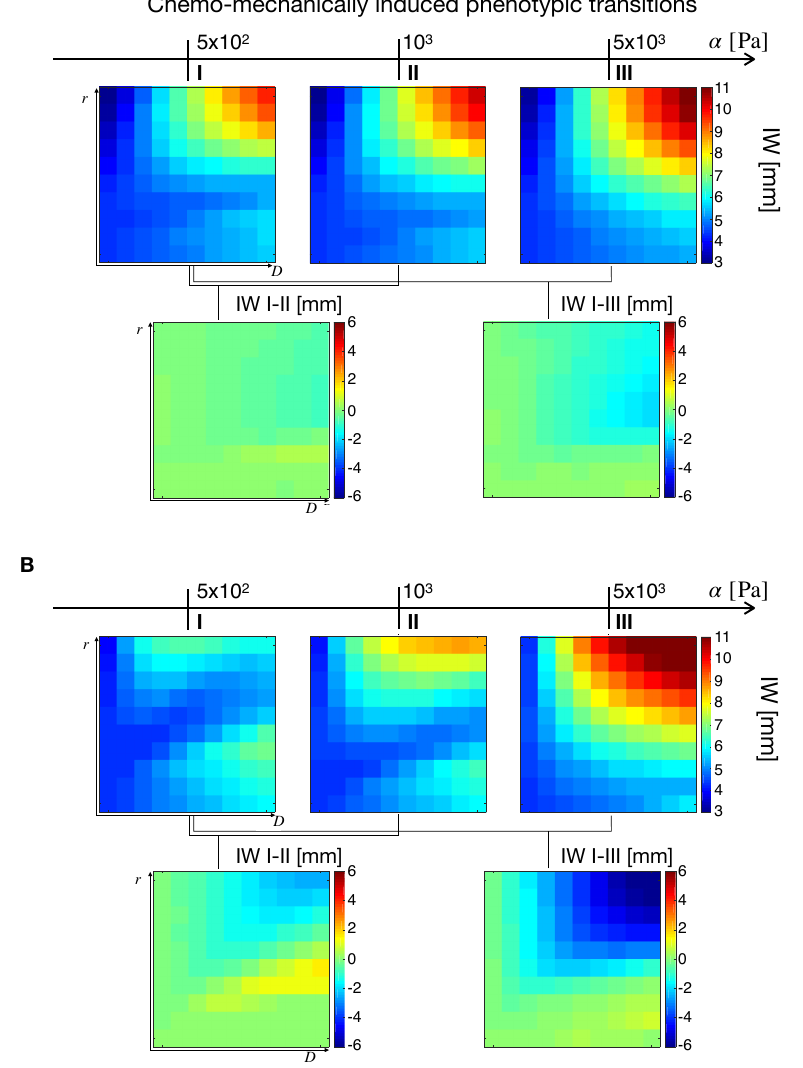
Figure 6. Simulation maps for the effects of chemo-mechanically induced transitions on tumor IW. In both cases ( A , B ), the top row shows three IW maps for different values of α , whereas the bottom row the IW variation occurring at different stiffness values. Simulations were obtained for ασ − 1 = [ 10 − 2 ,10 − 1 ] with t n / t s = 0.5 ( A ) and t n / t s = 10 ( B